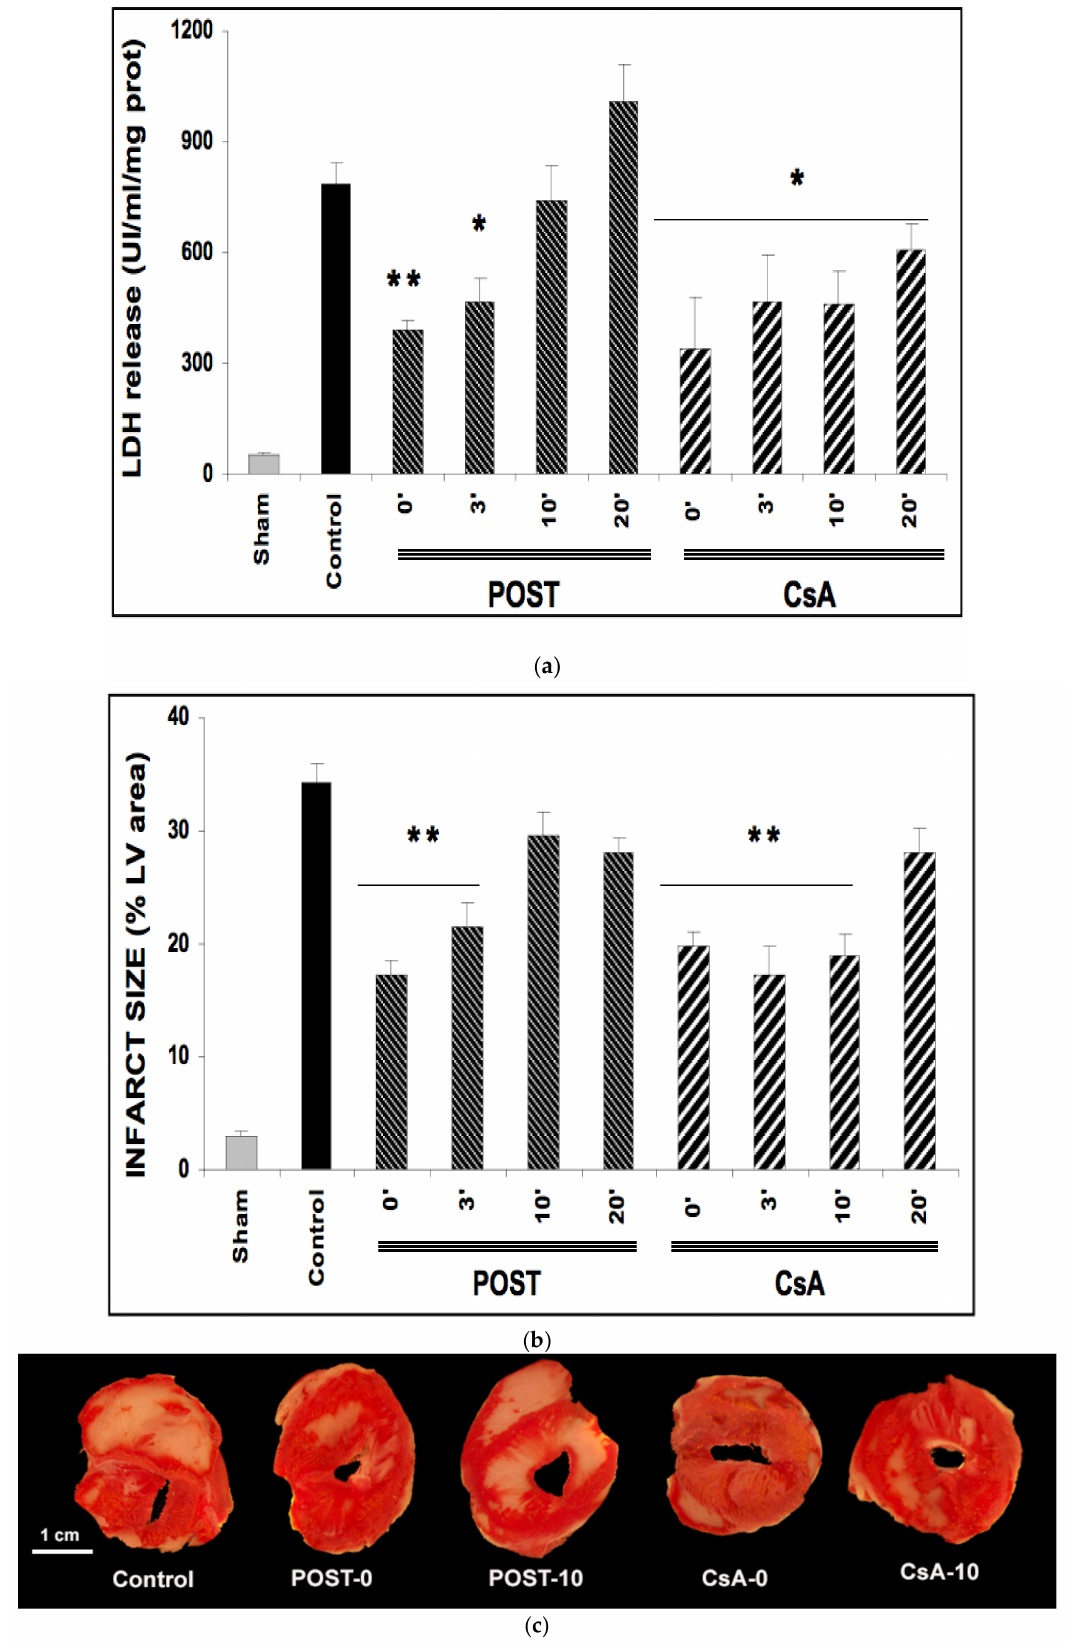
Figure 2. ( a ) : Myocardial necrosis assessed by LDH release (Panel a ) and infarct size measurement (Panel b ). Postconditioning (POST) lost its efficacy if delayed beyond 3 min of reperfusion,